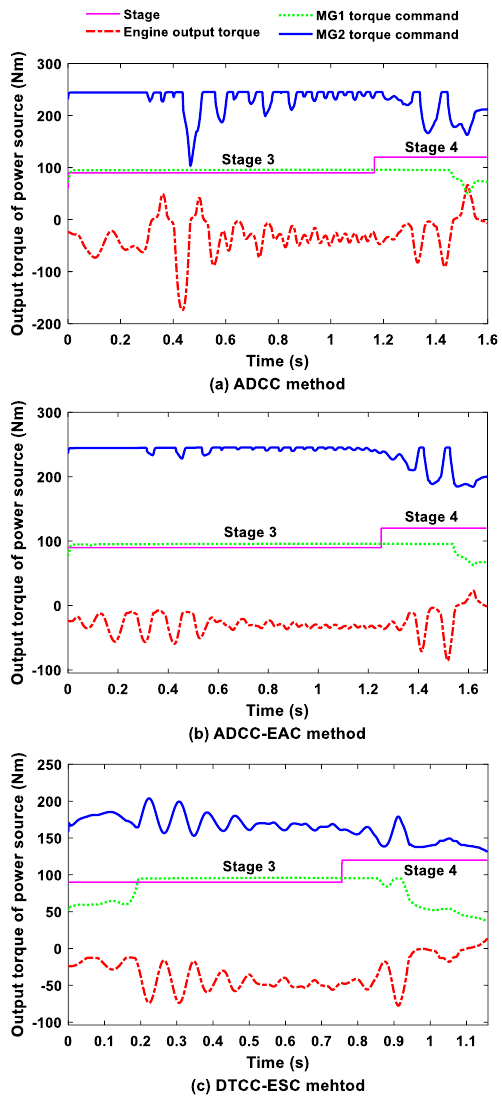
Figure 20. Comparison results of three control methods under case D: (a) output torque of power source; (b) output torque of power source; (c) output torque of power source.